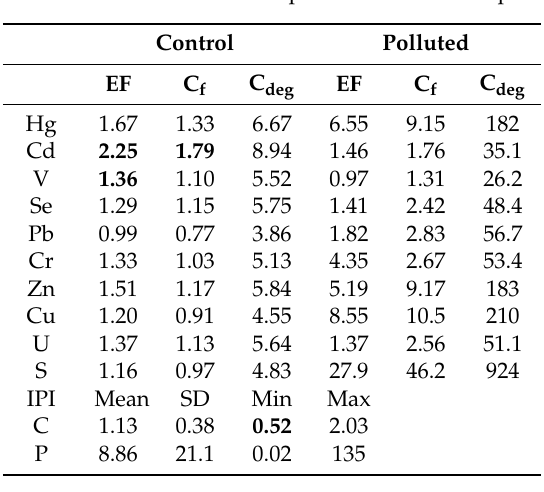
Table 5. Mean values of ecological risk indices (EF—enrichment factor, C f —contamination factor, C deg —contamination degree, and IPI—integrated pollution index) calculated for control and polluted (Labin) soil samples; numbers in bold exceed the respective values of the polluted soil